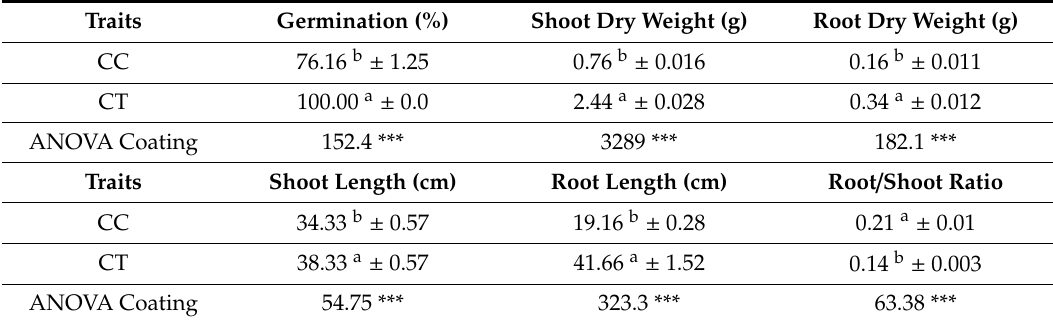
Table 1. The effects of thyme oil on seed germination and root and shoot dry weights and lengths of wheat plants.